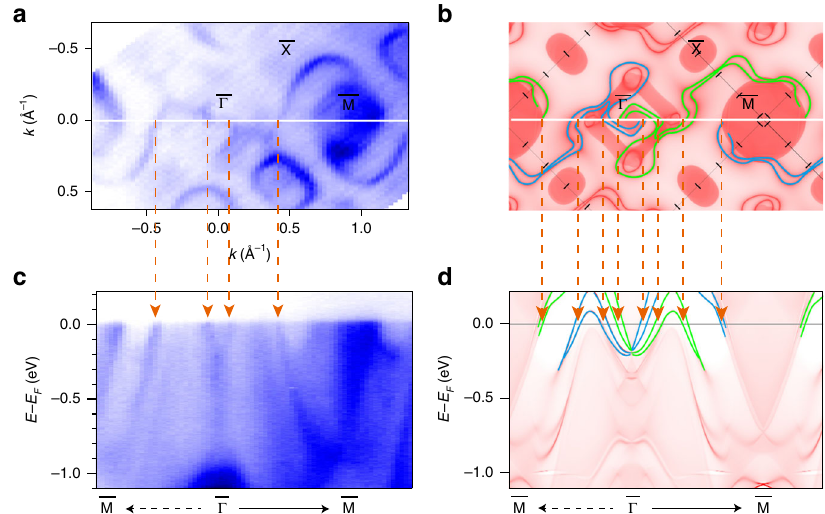
Fig. 3 PtGa band structure. a , b photon energy of, h ν = 67 eV. Calculated Fermi arcs are highlighted with green and blue lines. c , d ntensity plot is acquired with h ν = 60 eV. Orange arrows indicate the crossing positions of chiral Fermi arcs with E F . Both the calculated constant energy contour and the band structure are rigidly shifted by 100 meV to match the ARPES